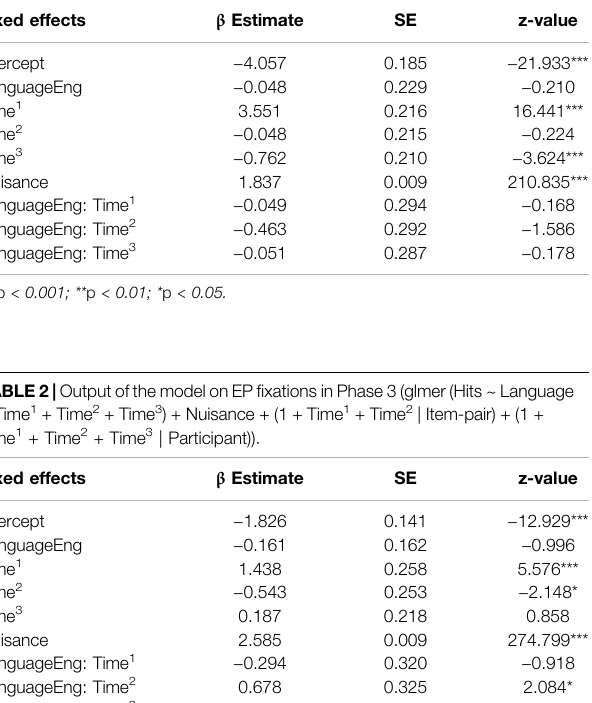
TABLE 1| Output ofthe modelonEP fi xations inPhase2(glmer (Hits~Language * (Time 1 + Time 2 + Time 3 ) + Nuisance + (1 | Item-pair) + (1 | Participant)).